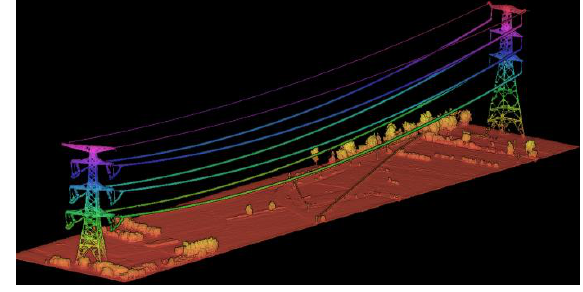
Figure 3. Decomposition of a T type